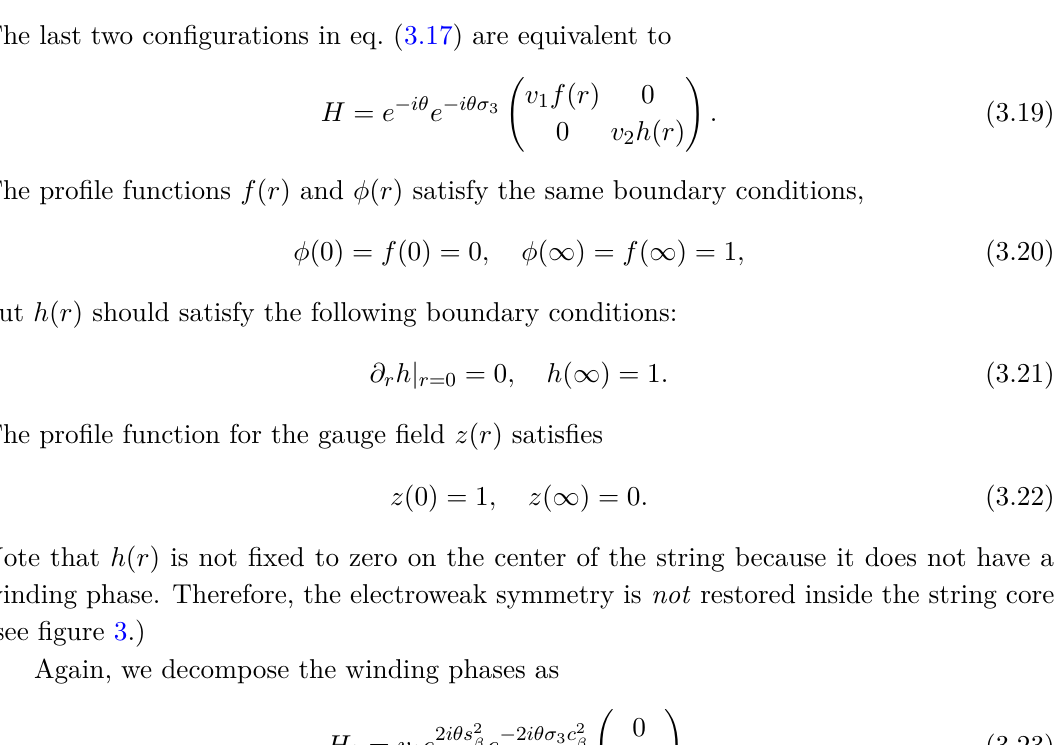
Figure 2 . Numerical solution for the type-A string. We take benchmark parameters as eq. (3.16) and v s = 10 v . Also we adopt a length unit as v − 1 = 0 . 5 . (left): plots of profile functions. Note s f ( r ) (blue line) is equal to h ( r ) (dotted orange line) everywhere. φ ( r ) increases as φ ∼ v s r for r ∼ 0 while f = h ∼ vr . All of them approach to unity for r → ∞ . (right): plot of energy density E (eq. (3.11)) divided by v 2 /r 2 . Clearly, the energy density has a polynomial tail like r − 2 , instead s of an exponential one. This leads to the logarithmically divergent tension. The integrated value of the tension over 0 ≤ r ≤ 120 v − 1 is 140 . 321 s